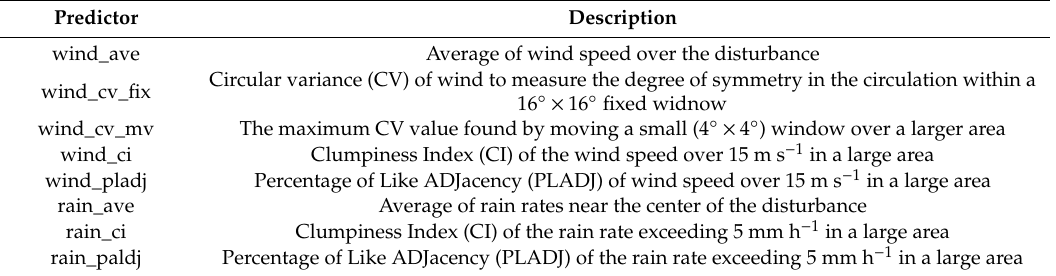
Table 1. Description of predictors that quantitatively describe dynamic and hydrological characteristics related to tropical cyclone (TC)